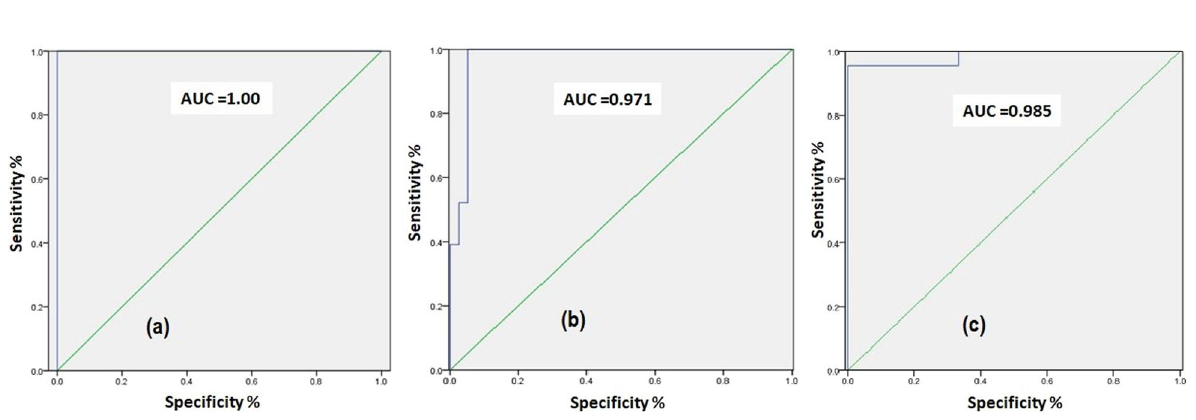
Fig. 2 Roc curves for sensitivity and specificity of GSDMD for detection of a TBPE, b MPE, and c